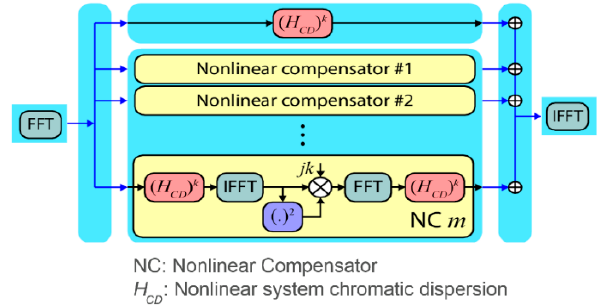
Figure 2. Inverse-Volterra series-transfer function (IVSTF) block diagram for coherent optical Figure 2. Inverse ‐ Volterra series ‐ transfer function (IVSTF) block diagram for coherent optical orthogonal frequency division multiplexing (CO-OFDM). Where m is the number of spans in a long-haul orthogonal frequency division multiplexing (CO ‐ OFDM). Where m is the number of spans in a long ‐ network and k is the Kernel order [13]. (I)FFT: (Inverse) fast Fourier haul network and k is the Kernel order [13]. (I)FFT: (Inverse) fast Fourier transform.